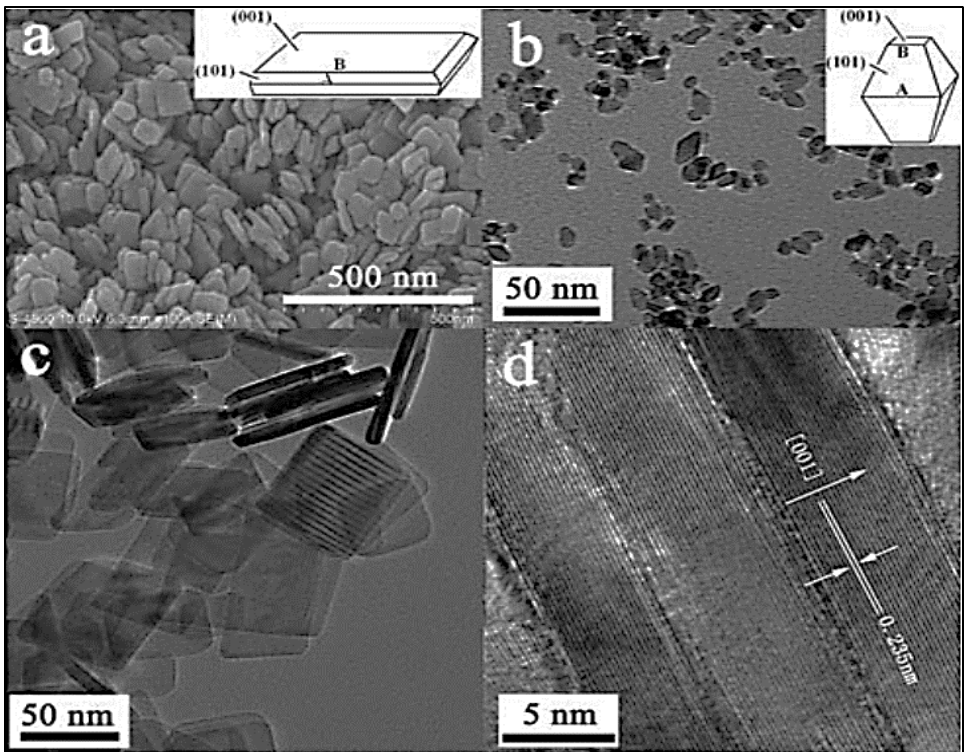
Figure 3. ( a ) SEM, ( b , c ) TEM, and ( d ) HR-TEM images of TiO 2 -NS. The images have been reproduced with permission [93].